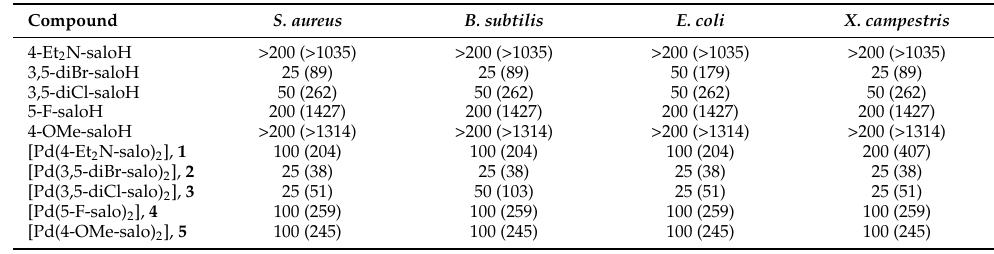
Table 2. Antimicrobial activity of X-saloH and complexes 1 – 5 expressed as MIC (in µ g/mL or µ M (values in